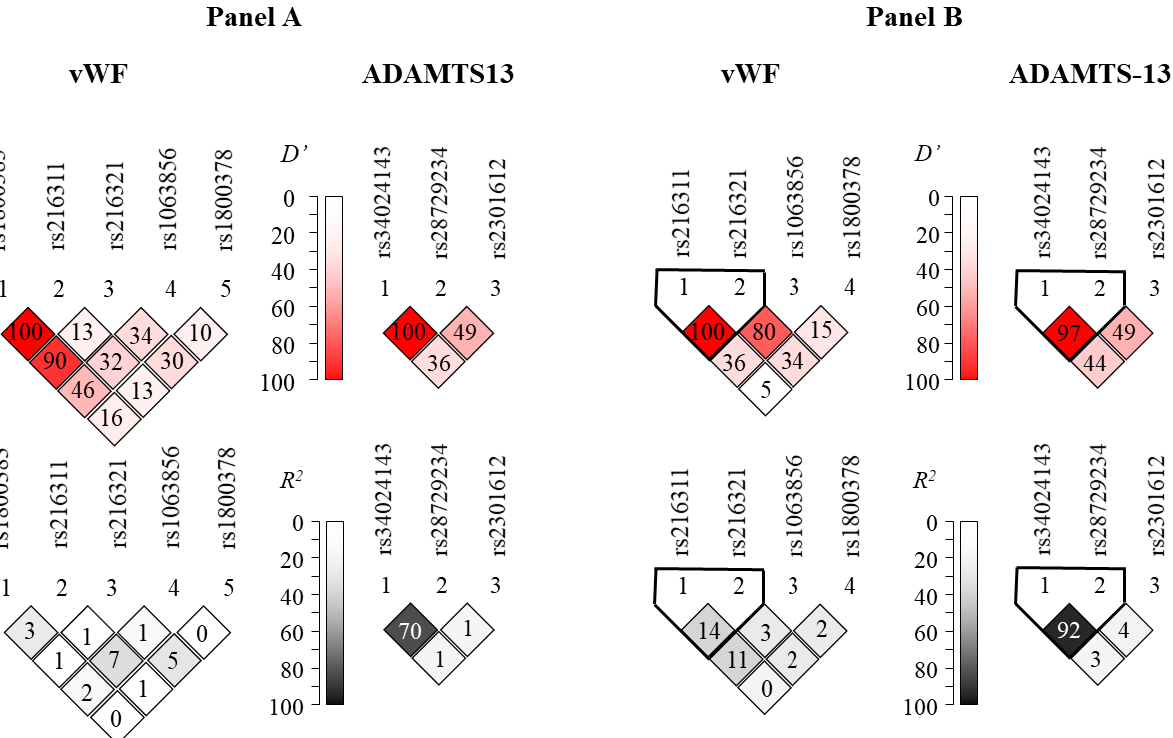
Figure 1. Representation of pairwise linkage disequilibrium analysis of SNPs genotyped in the vWF